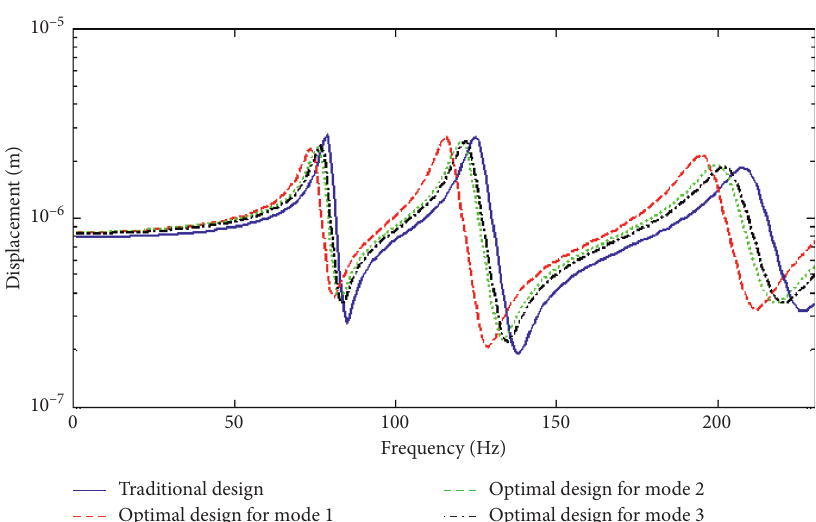
Figure 4: Comparison of the amplitude of frequency response function of traditional design and optimal designs.